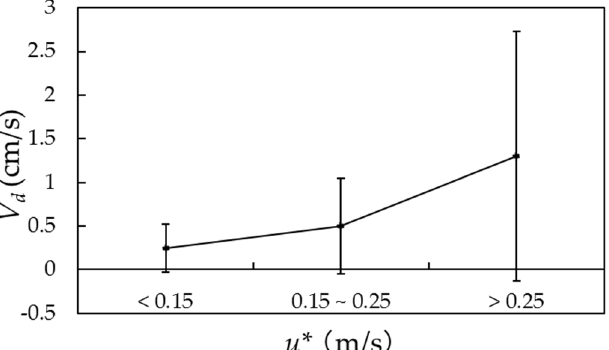
Figure 4. The relationship between deposition velocities V d and friction velocities u* . V d is the mean value based on different ranges of u * in May 2013 in both sites. The error bars are the standard errors of mean V d values at each range of u *.